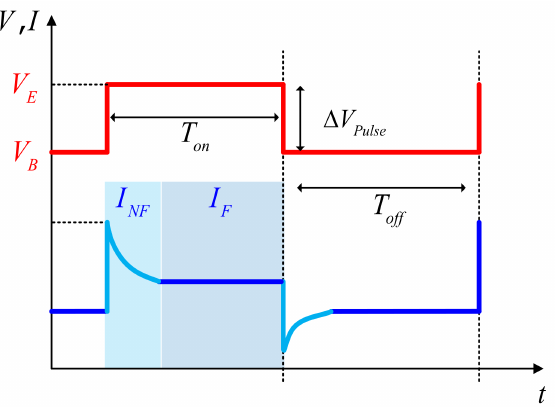
Figure 1. Pulse operation by voltage